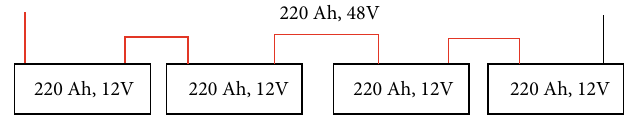
Figure 21: Battery con fi guration house 4.